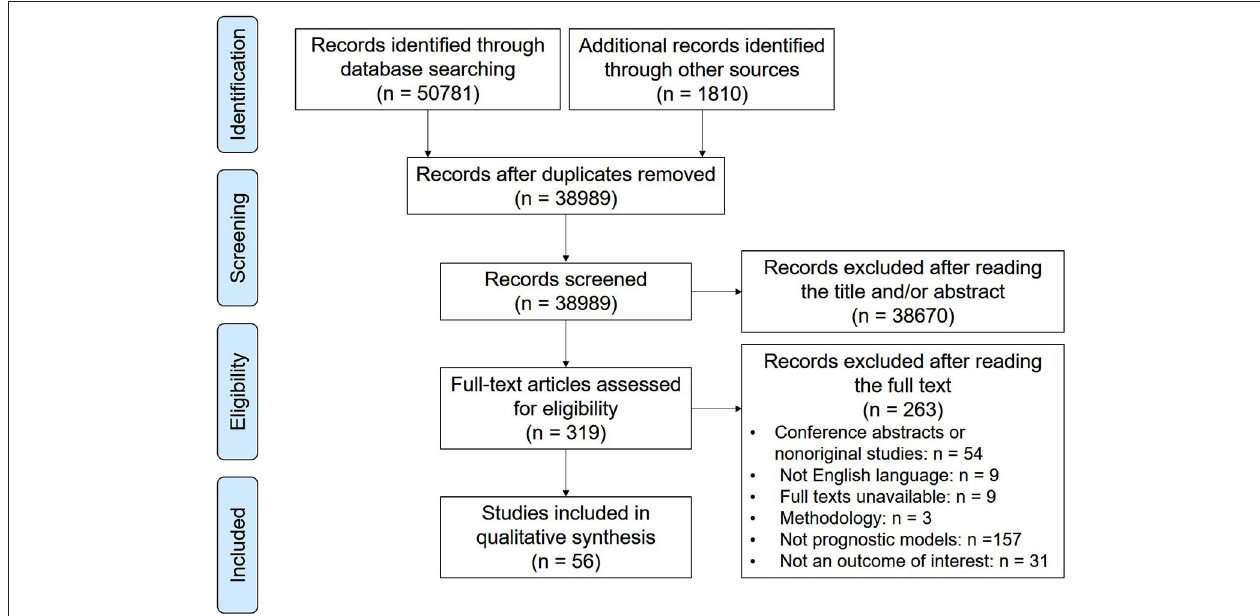
FIGURE 1 | Flow chart of the literature search for prognostic models related to cervical cancer.